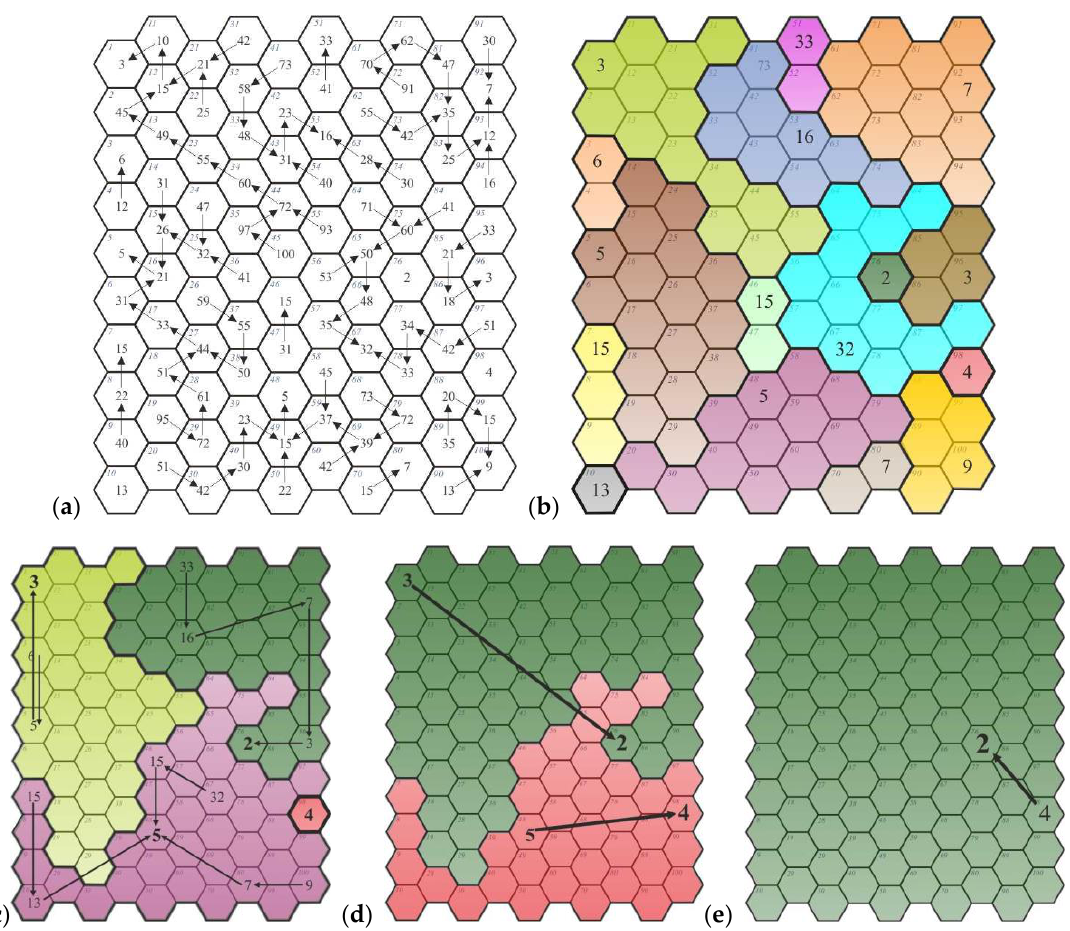
Figure 3. The stages of network emergence according to the minimum value decrease path: ( a ) the stage of revealing the minimum value decrease relationship; ( b ) the first stage of value aggregation; ( c ) the second stage of value aggregation; ( d ) the third stage of value aggregation; ( e ) the fourth stage of value aggregation.